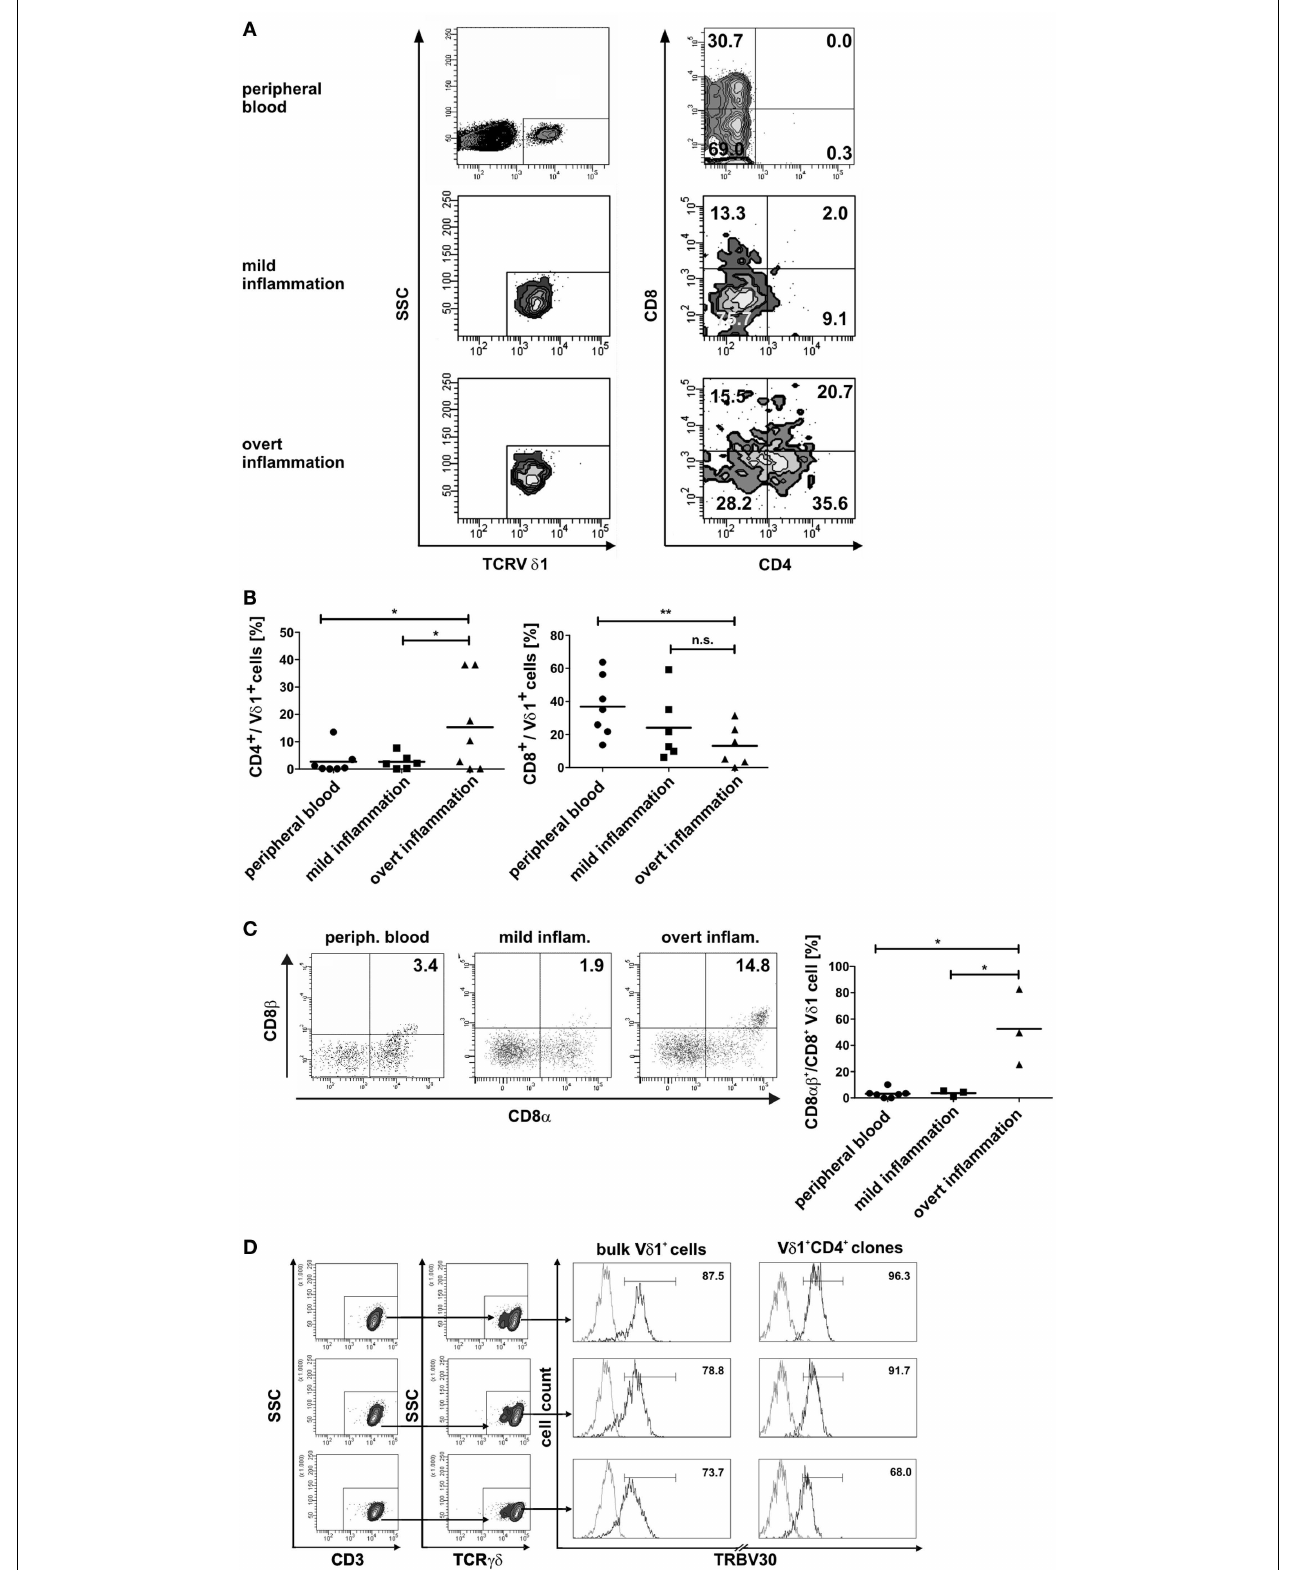
FIGURE 9 | Phenotypic changes of panV δ 1 + T cells in inflammatory conditions